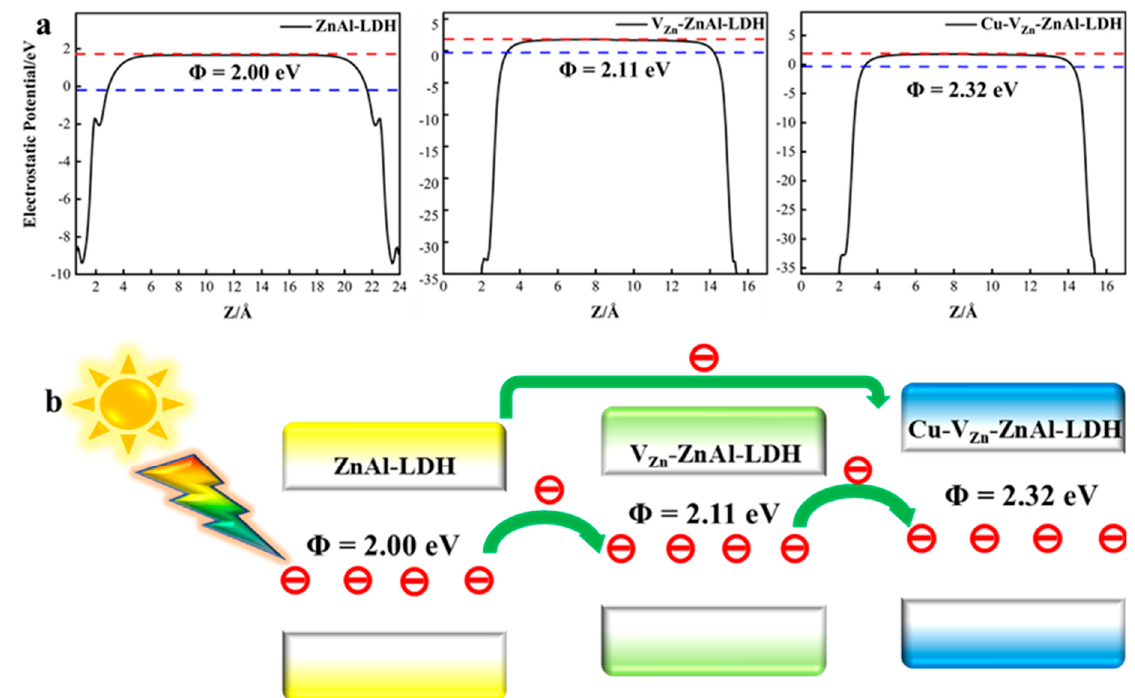
Figure 6 . ( a ) Work function of the three ZnAl-LDHs where the red and blue lines represent the vaccum and the Fermi level, respectively; ( b ) electron transfer between ZnAl-LDHs .